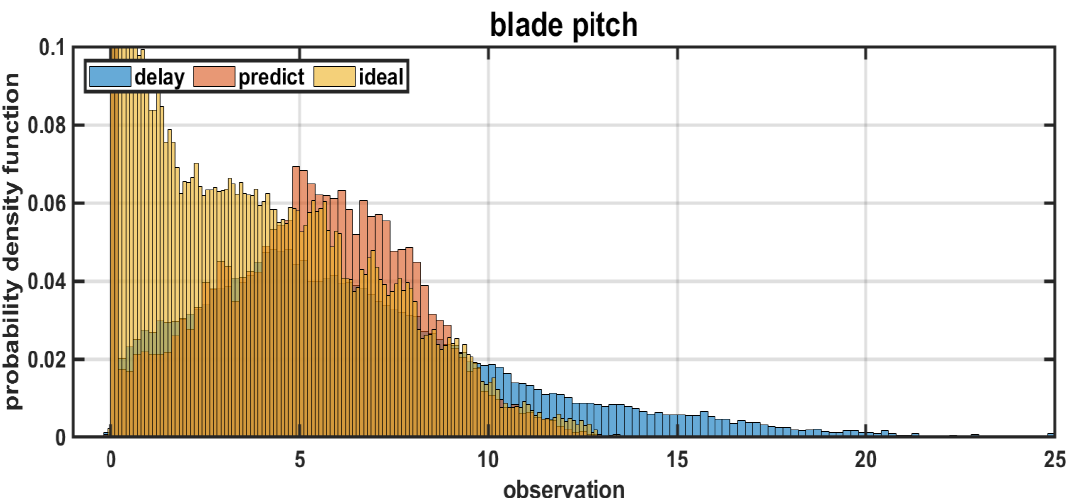
Figure 15. Histogram of blade pitch angle of floating offshore wind turbine by pitch controller.